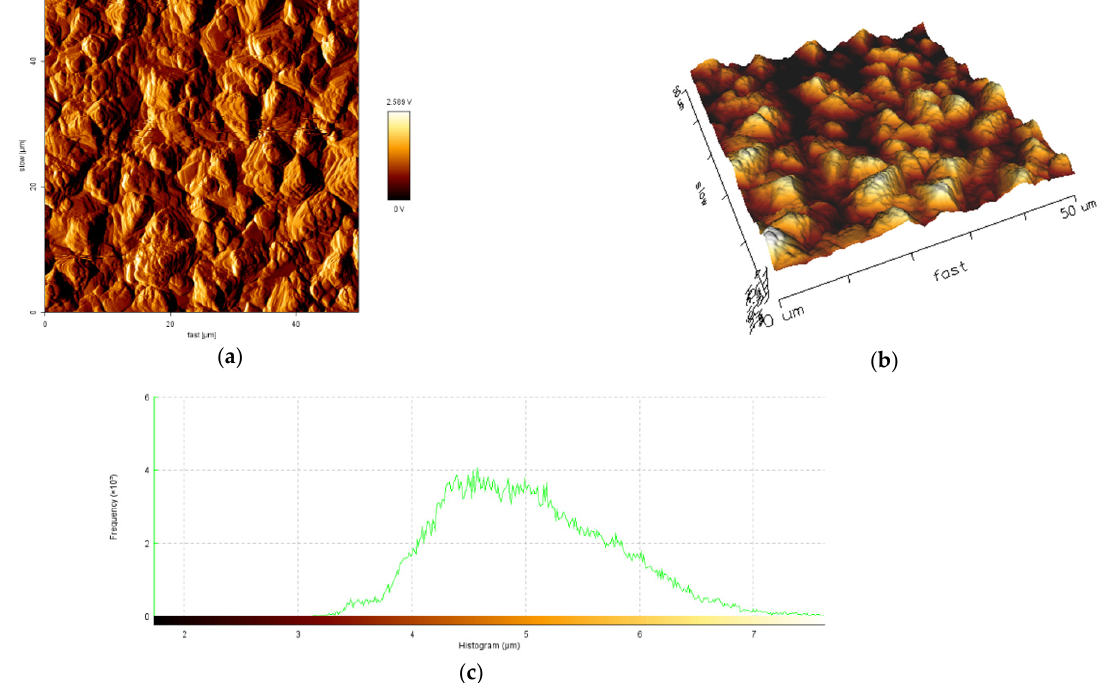
Figure 5. 50 × 50 μ m 2 AFM images of sample B: ( a ) 2D image; ( b ) 3D image; ( c ) histogram of the scanned surface.